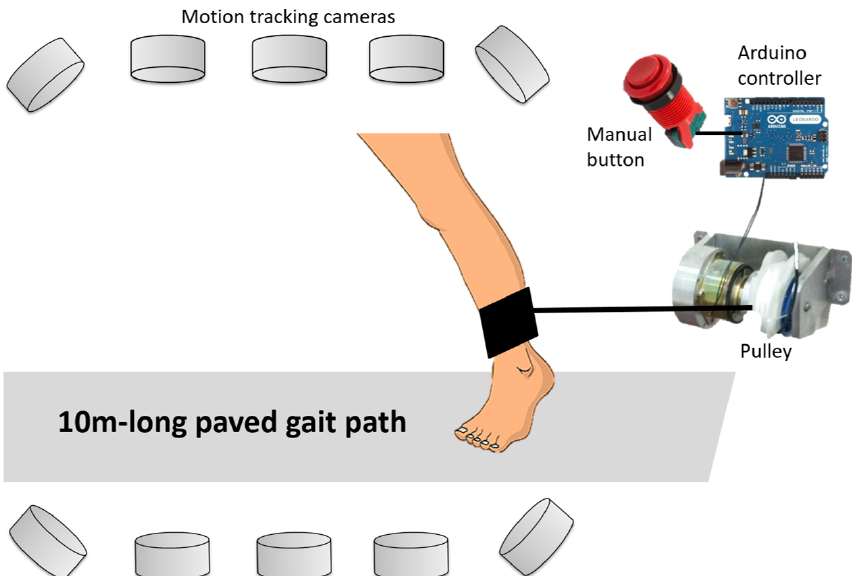
Figure 2. The subjects walked on a 10 m-long paved path surrounded by 10 motion-tracking cameras. A manually-controlled electronic locking mechanism was attached to the ankle by a strap. A cable from the strap is released from a wall-mounted pulley, set at one end of a 10 m path at ankle height. Locking of the pulley was controlled by a mechanism based on a relay shield, an Arduino controller, and a manual button. When pressing a button, the cable is locked and then released after a duration of 200 ms, causing a short gait